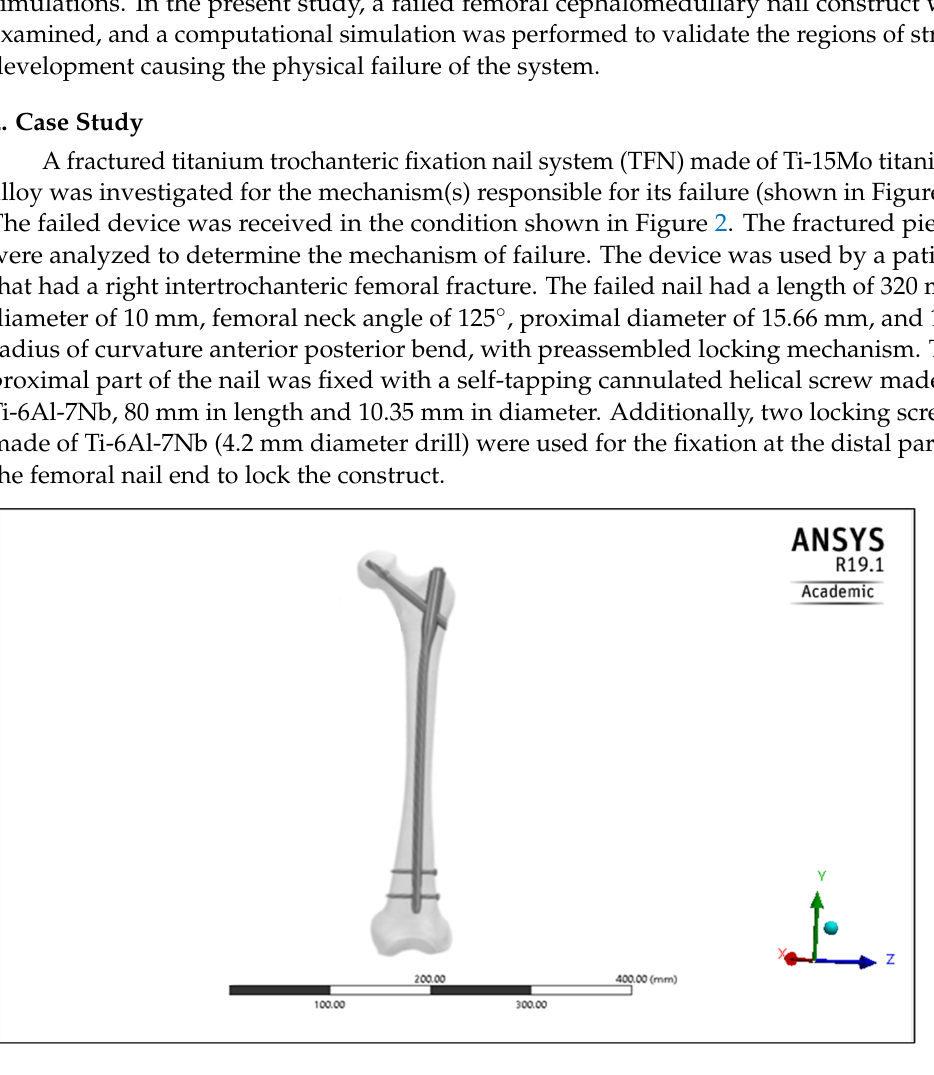
Figure 1. The femoral cephalomedullary nail inside the femoral bone.